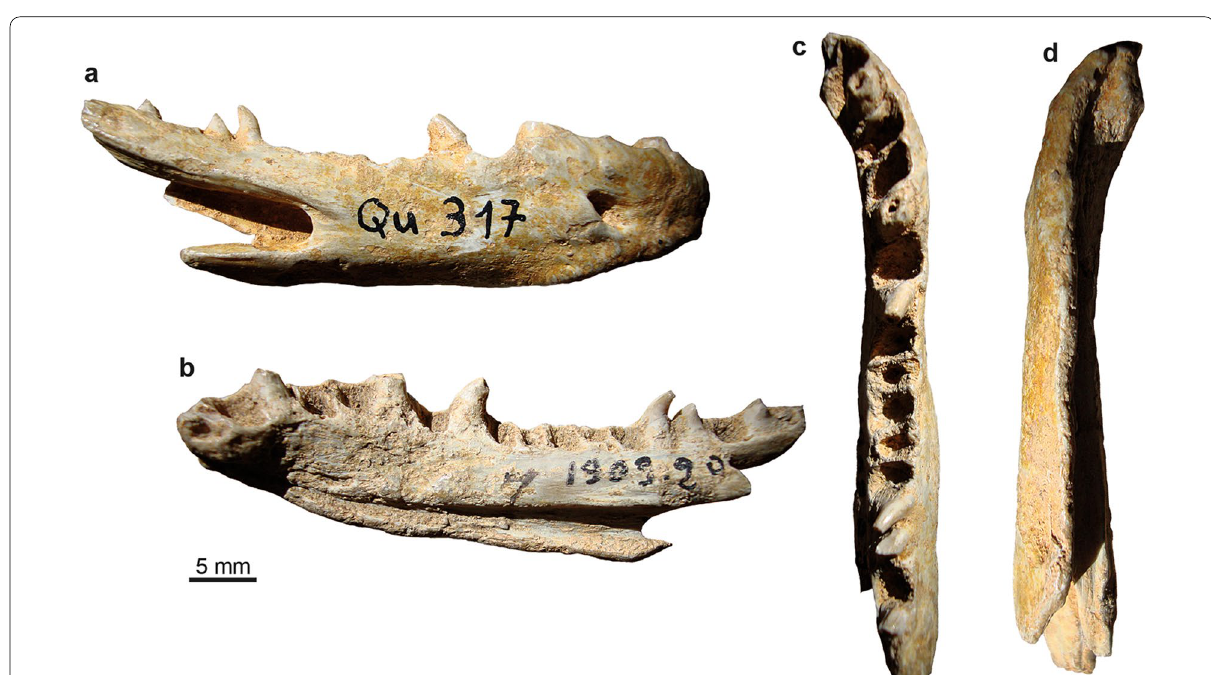
Fig. 6 Palaeopython cadurcensis from an imprecisely known locality in the Phosphorites du Quercy, paralectotype: right dentary (MNHN.F QU16317) in labial ( a ), medial ( b ), dorsal ( c ), and ventral ( d )